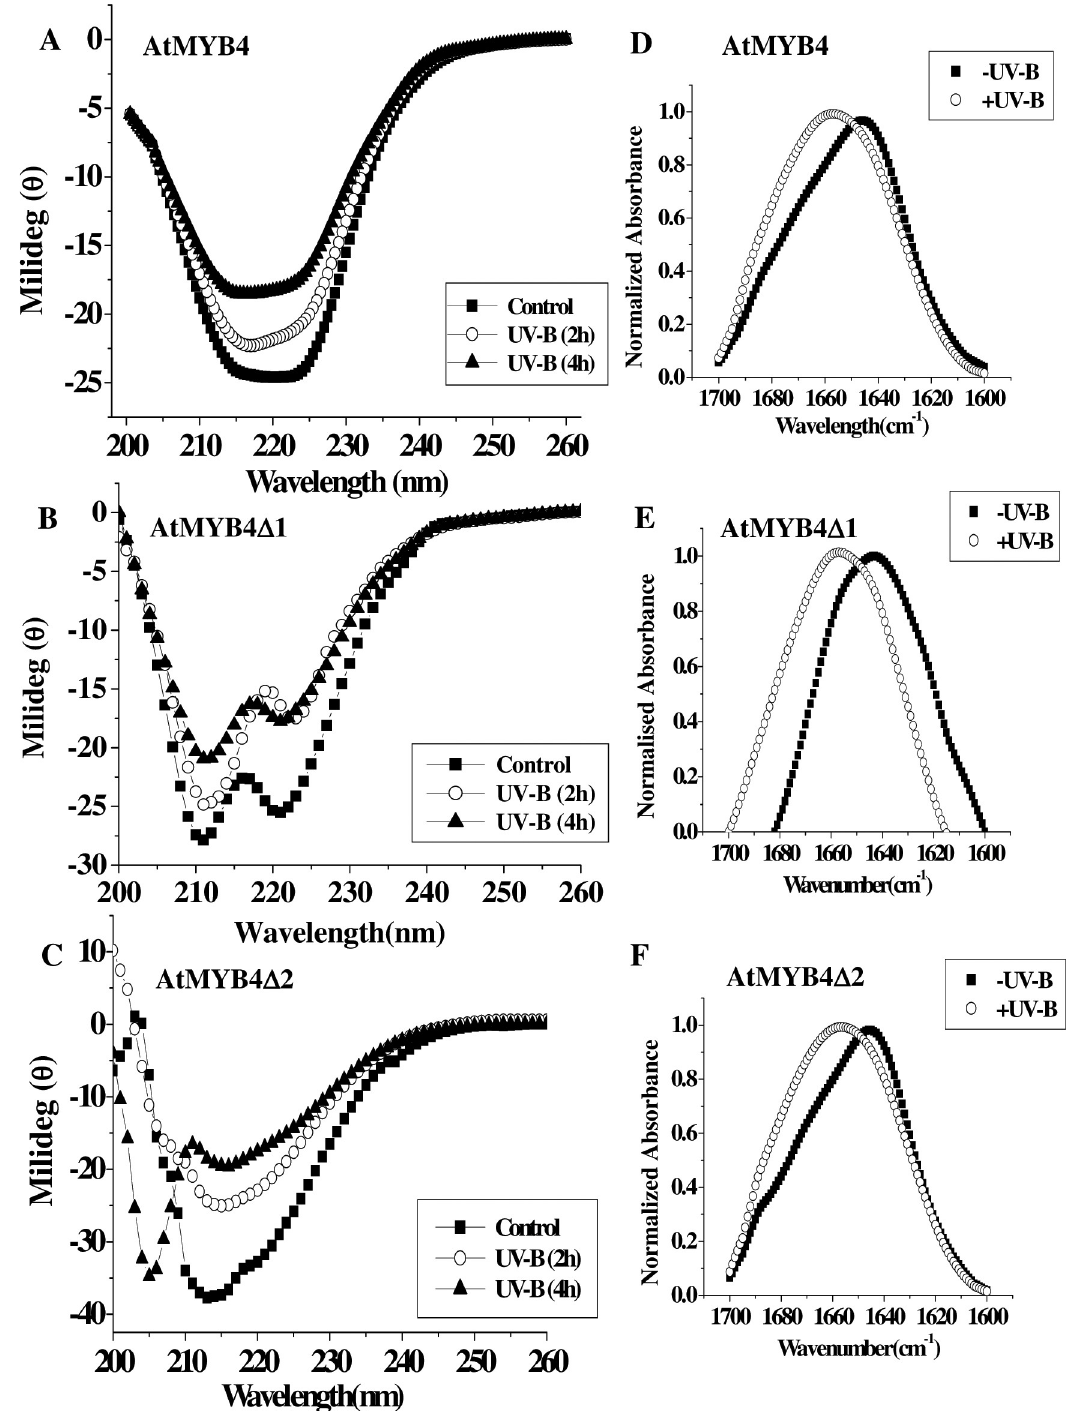
Fig 6. Evaluation of changes in the secondary structure of AtMYB4, AtMYB4 Δ 1 and AtMYB4 Δ 2 proteins by far-UV CD and Fourier transform infrared spectroscopy (FTIR). A-C.Far-UV CD spectra of untreated control, 2h and 4h UV-B irradiated AtMYB4 (A), AtMYB4 Δ 1 (B) and AtMYB4 Δ 2 (C) proteins, respectively. D-F.Amide I FT-IR spectra of untreated control and 4 h UV-B irradiated (~200 J/m 2 )AtMYB4 (D), AtMYB4 Δ 1 (E) and AtMYB4 Δ 2 (F) proteins.